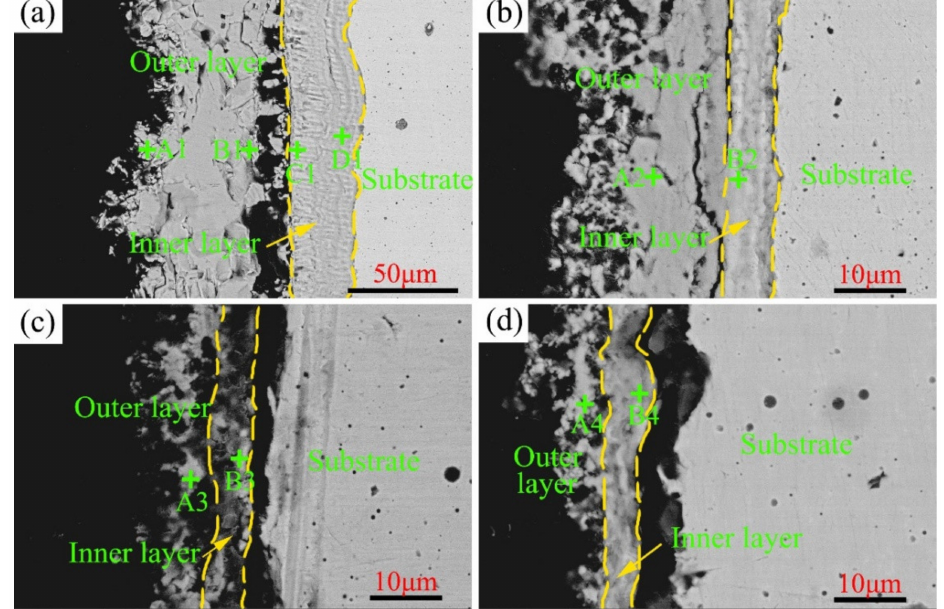
Figure 9. Cross-section morphology of Ni–xCr–Mo laser-cladding coatings under back-scattered